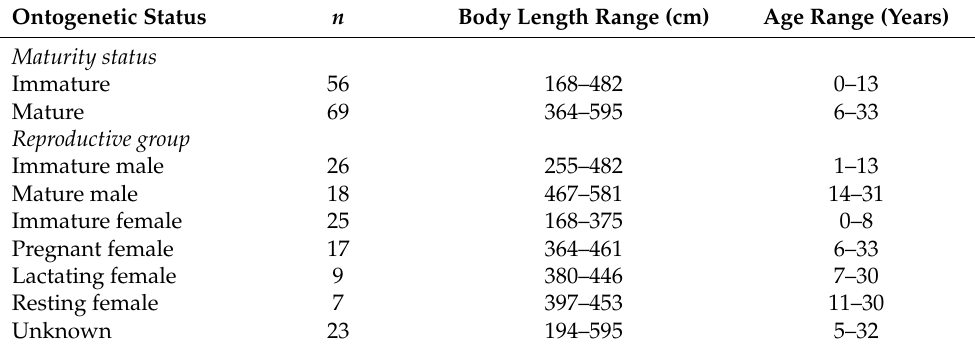
Table 1. Ontogenetic characteristics of long-finned pilot whales ( Globicephala melas edwardii ) sampled for stable isotope analysis from mass-strandings on the New Zealand coast, 2009–2017. Unknown refers to individuals where reproductive group was unable to be determined from reproductive organs, but maturity status was instead classified from body